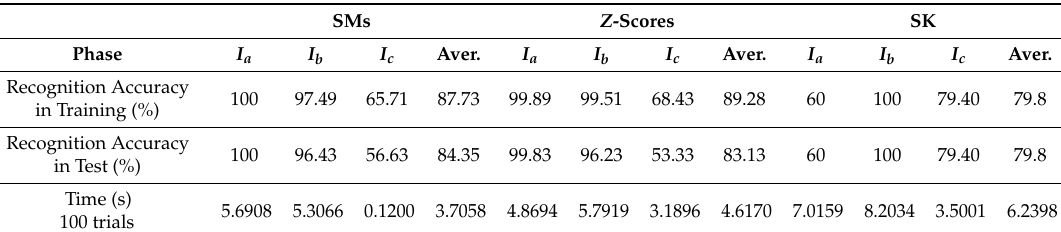
Table 4. Results of SLGF on the line faults with the BP-ANN.